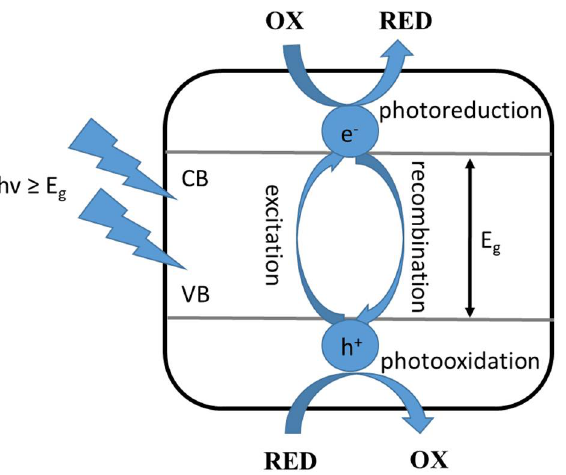
Figure 1. Excitation of a semiconductor photocatalyst, where: OX—oxidized compound, RED—reduced compound, VB—valence band, CB—conduction band, Eg—the energy of the excited band, hv—the energy of the radiation quantum [3].